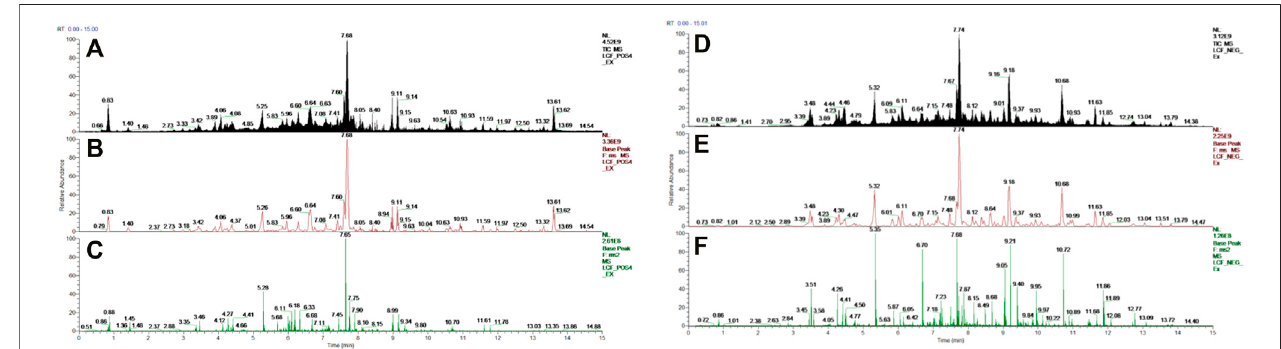
FIGURE 1 | UHPLC-Orbitrap-MS spectrometry of LCF. (A,D) Total ion current chromatograms; (B,E) base peak of MS; (C,F) base peak of MS2.